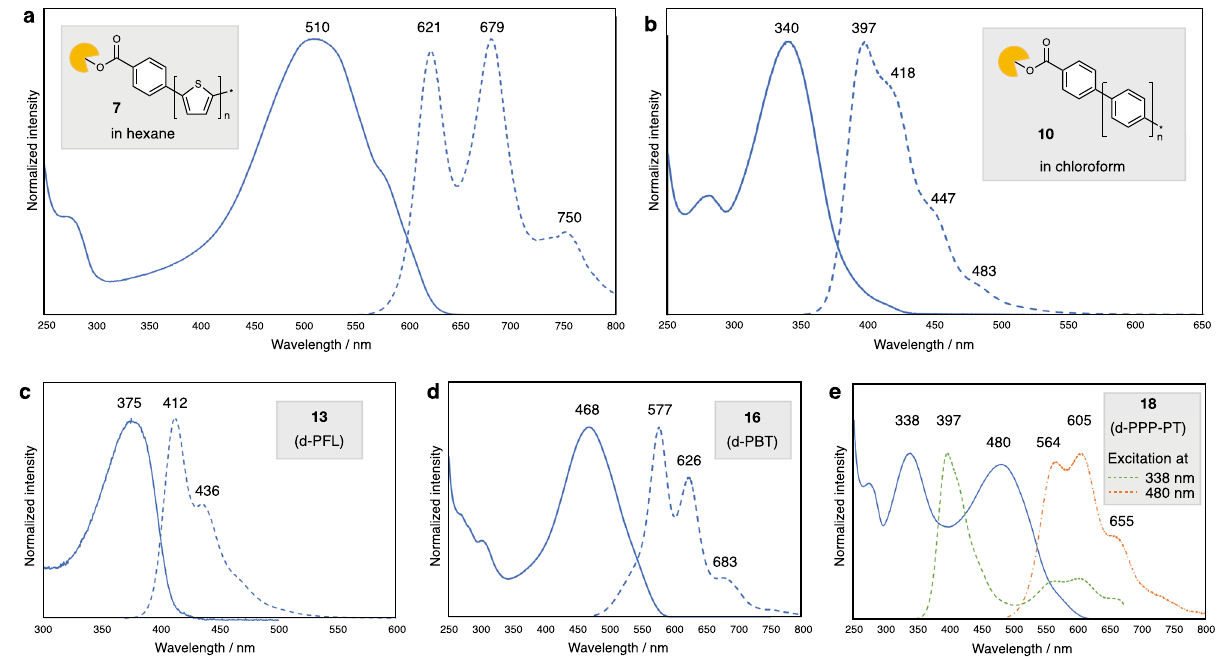
Fig.5|Photophysicalpropertiesofpolythiophenes7and8.a UV/visabsorption (solid line) and fl uorescence (broken line) spectra of the hexane solution of 7 . Fluorescence spectrum was taken upon excitation at 510nm. b UV/vis absorption (solidline)and fl uorescence(brokenline)spectraofthechloroformsolutionof 10 . Fluorescence spectrum was taken upon excitation at 340nm. c UV/vis absorption (solid line) and fl uorescence(broken line) spectraof the chloroform solution of 13 (d-PFL). Fluorescence spectrum was taken upon excitation at 360nm. d UV/vis